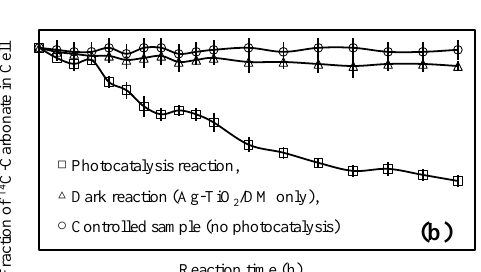
Figure 5. Relative changes in photosynthetic activity of Oscillateria tenuisa ( a ) and Microcystis aeruginosa ( b ) during photocatalytic reaction.